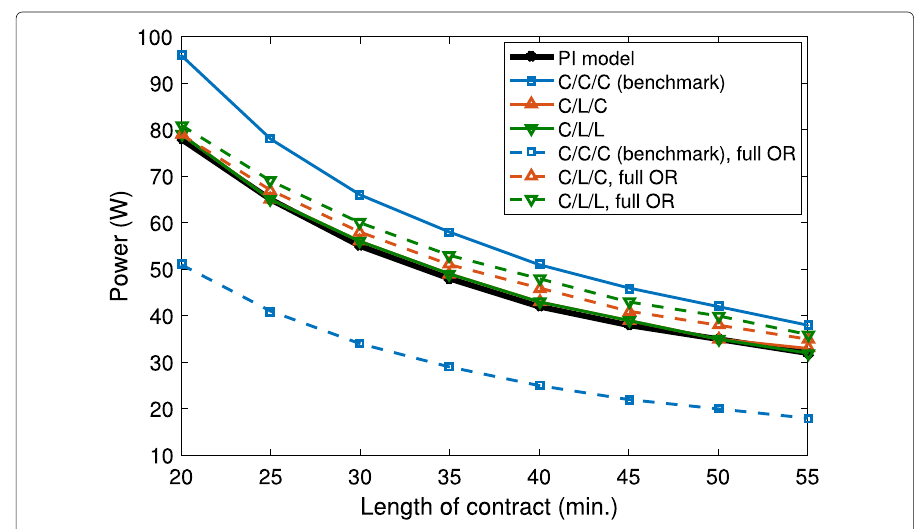
Fig. 10 Computed vs. full OR calibration for the regulation application